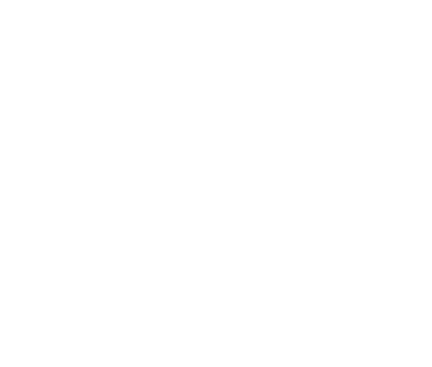
Fig 1. The structures of the compounds used in this